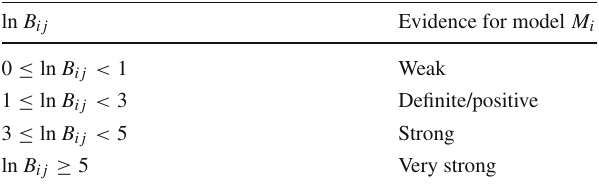
Table 7 Revised Jeffreys scale quantifying the observational viability of any cosmological model M i compared to some reference model M j